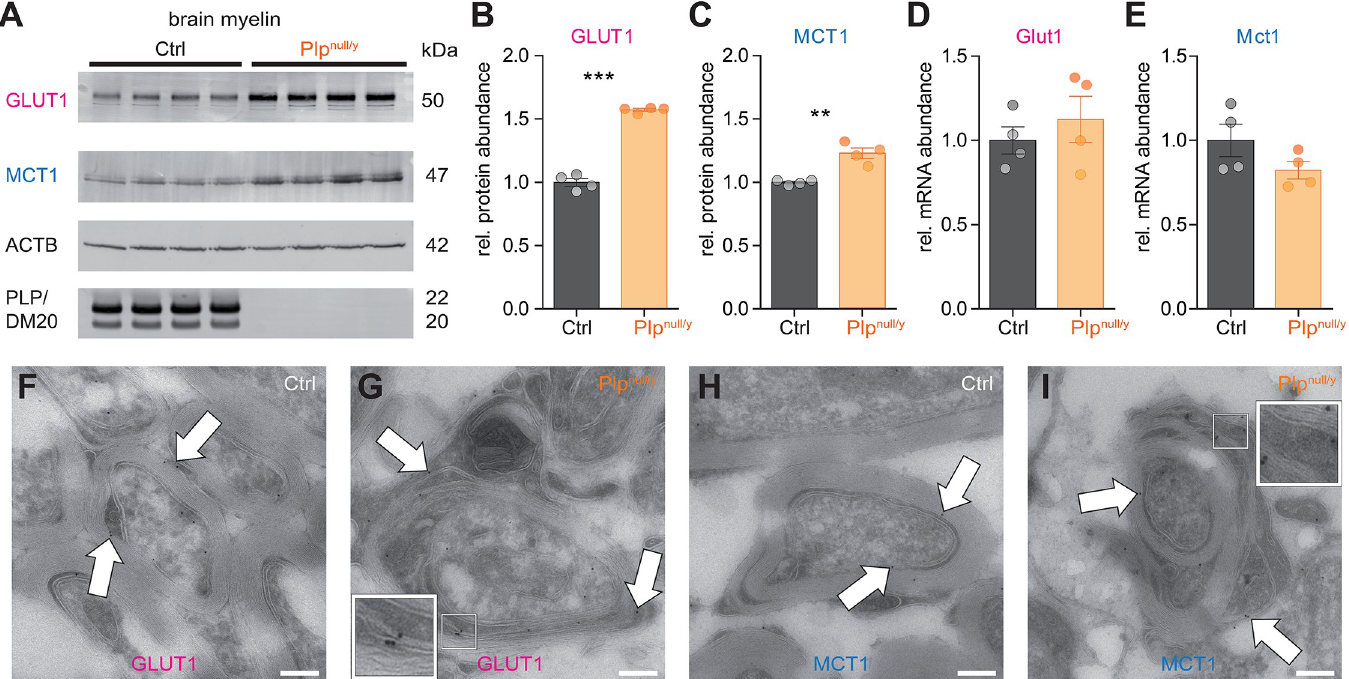
Fig 6. Abundance and localization of GLUT1 and MCT1 in myelin. (A) Immunoblot analysis of myelin purified from the brains of wild-type (control [Ctrl]) and Plp null/y mice probed for glucose transporter 1 (GLUT1) and monocarboxylate transporter 1 (MCT1). β -actin (ACTB) was detected as a loading control; PLP/DM20 was detected as genotype control. Blot represents N = 4 individual mice for each genotype. (B and C) Genotype-dependent quantification of the immunoblots for GLUT1 (B) and MCT1 (C). The abundance of both proteins is significantly increased in myelin purified from Plp null/y brains ( N = 4 mice for both genotypes). (D and E) Quantitative RT-PCR analysis of the abundance of Glut1 (D) and Mct1 (E) mRNAs in the corpus callosum dissected from wild-type (Ctrl) and Plp null/y mice ( N = 4 mice for both genotypes). In (B–E): �� p < 0.01, ��� p < 0.001; Student t test. (F–I) Cryo-immuno electron microscopy to assess the localization of GLUT1 (F and G) and MCT1 (H and I) protein in the myelin of optic nerves dissected from wild-type (F and H) and Plp null/y (G and I) mice. White arrows point at gold particles indicating localization of the respective proteins. The scale bars in (F–I) correspond to 200 nm. White boxes are 2.6 × zoomed-in magnification of the corresponding box highlighting the gold particles. Original, uncropped Western blots are available in S1 Raw Images. Data underlying this figure can be found in S1 Data.